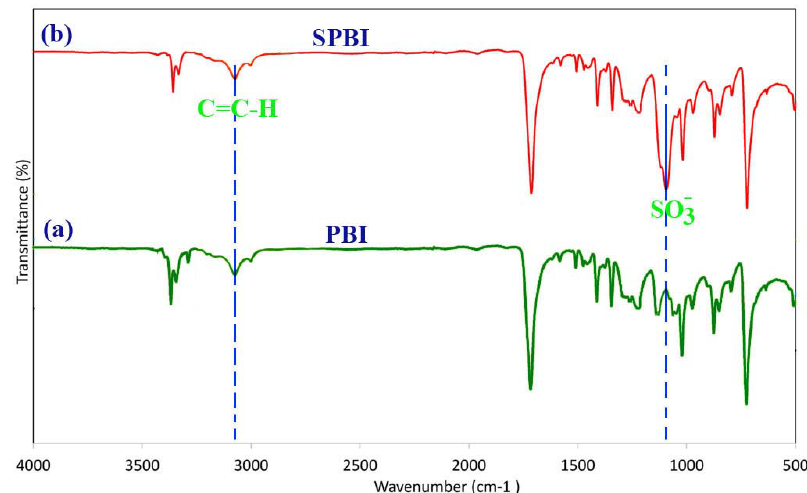
Fig. 1. Fourier transform infrared (FT-IR) spectra of polybenzimidazole (PBI) and sulfonated PBI